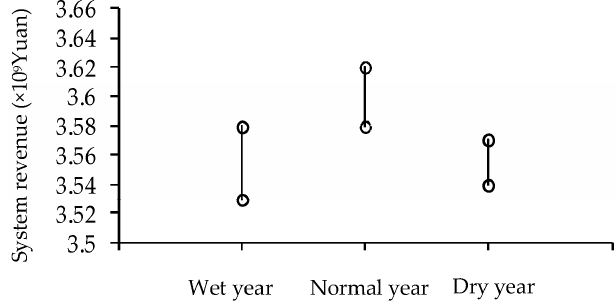
Figure 7. The system revenue in different scenarios in Minqin Oasis.